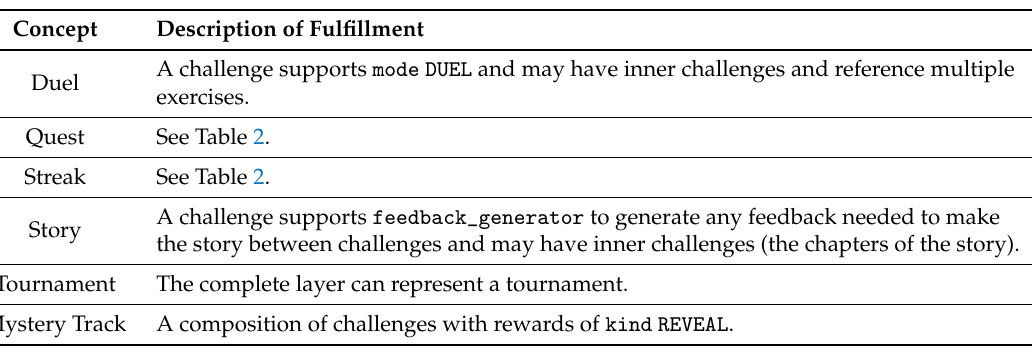
Table 6. Fulfillment of requirements of complex